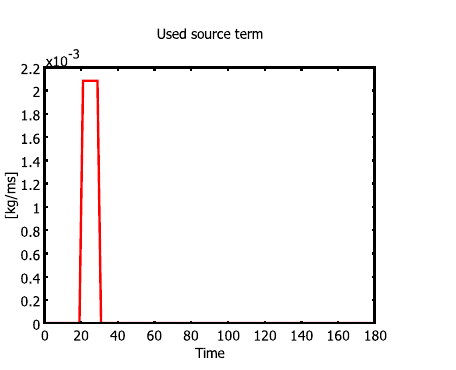
Figure 2. The used source term in Eq.